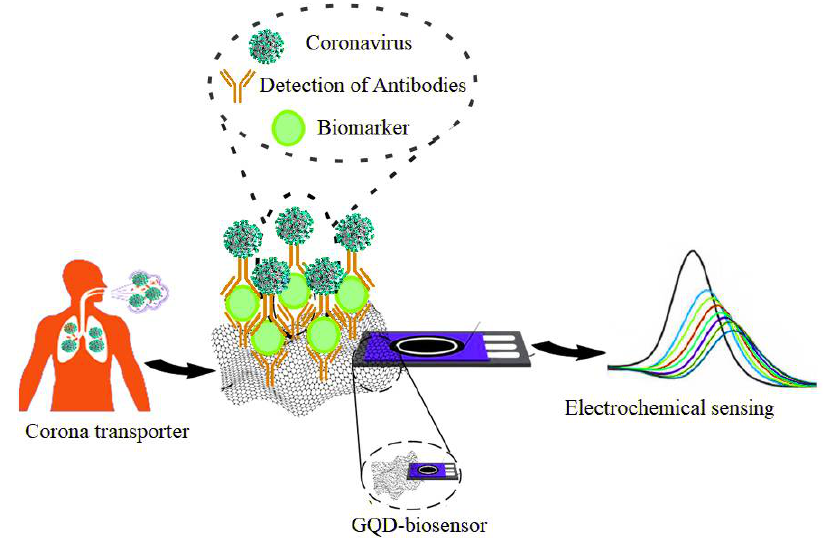
Figure 8. Detection of coronaviruses by using QD-based graphene biomarker.